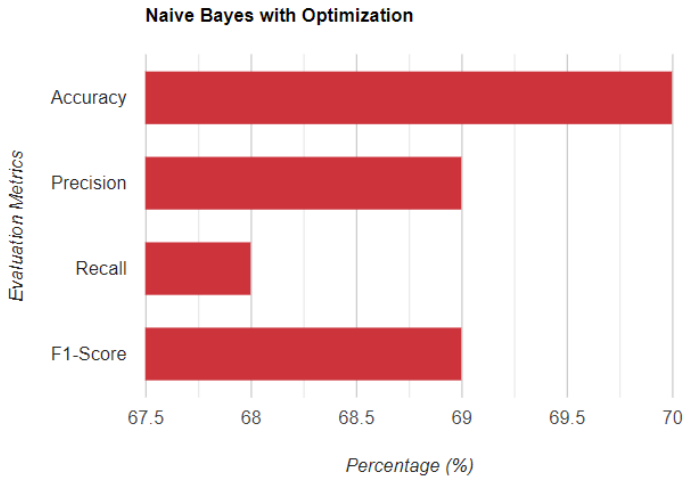
Figure 15. Naive Bayes Algorithm Performance After